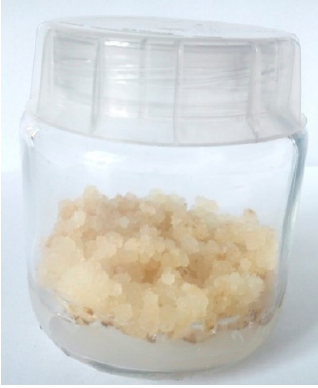
Figure 2. P. coccineus 10-day callus culture.